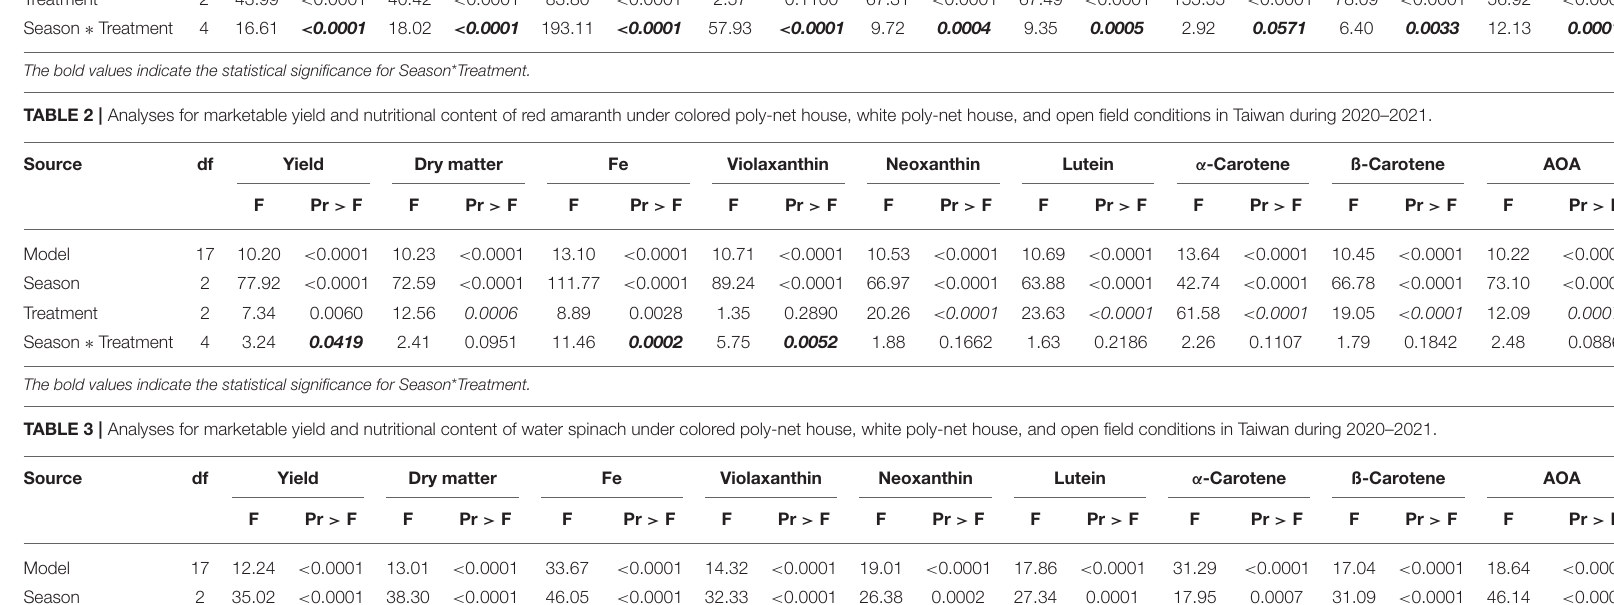
The bold values indicate the statistical significance for Season *